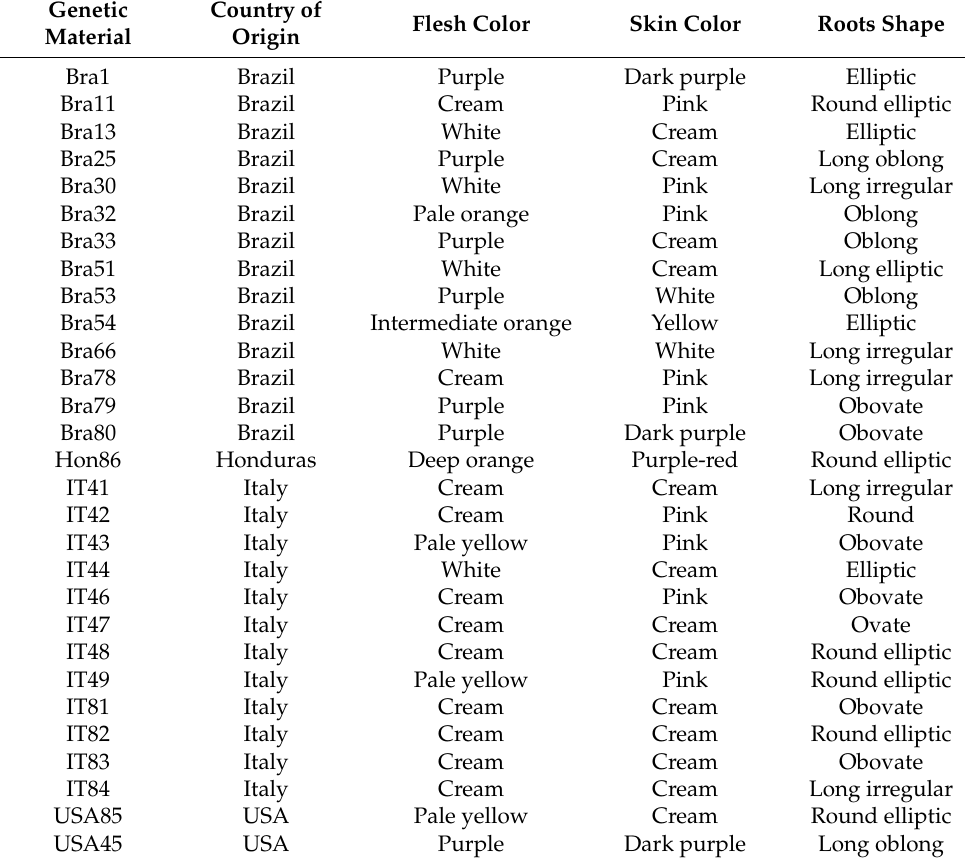
Table 1. List of the sweet potato genetic materials and their main morphological